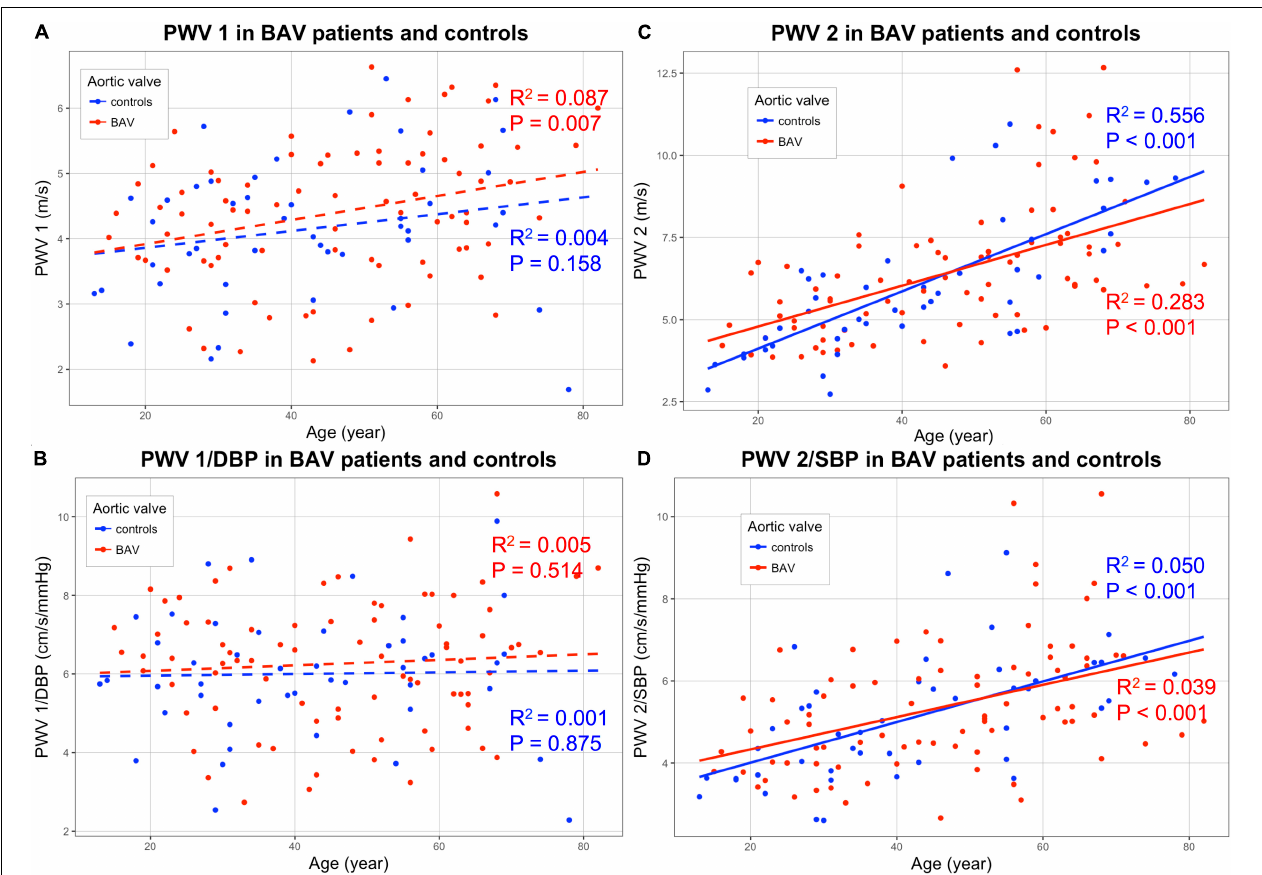
FIGURE 3 | Correlations of following stiffening indicators ( Y -axis) with age ( X -axis): PWV 1 (A) ; (PWV1/DBP) (B) ; PWV2 (C) and PWV2/SBP (D) , for patients with bicuspid aortic valve (BAV) (red) and controls (blue). BAV, bicuspid aortic valve; PWV, pulse wave velocity; DBP, diastolic blood pressure; SBP, systolic blood pressure.